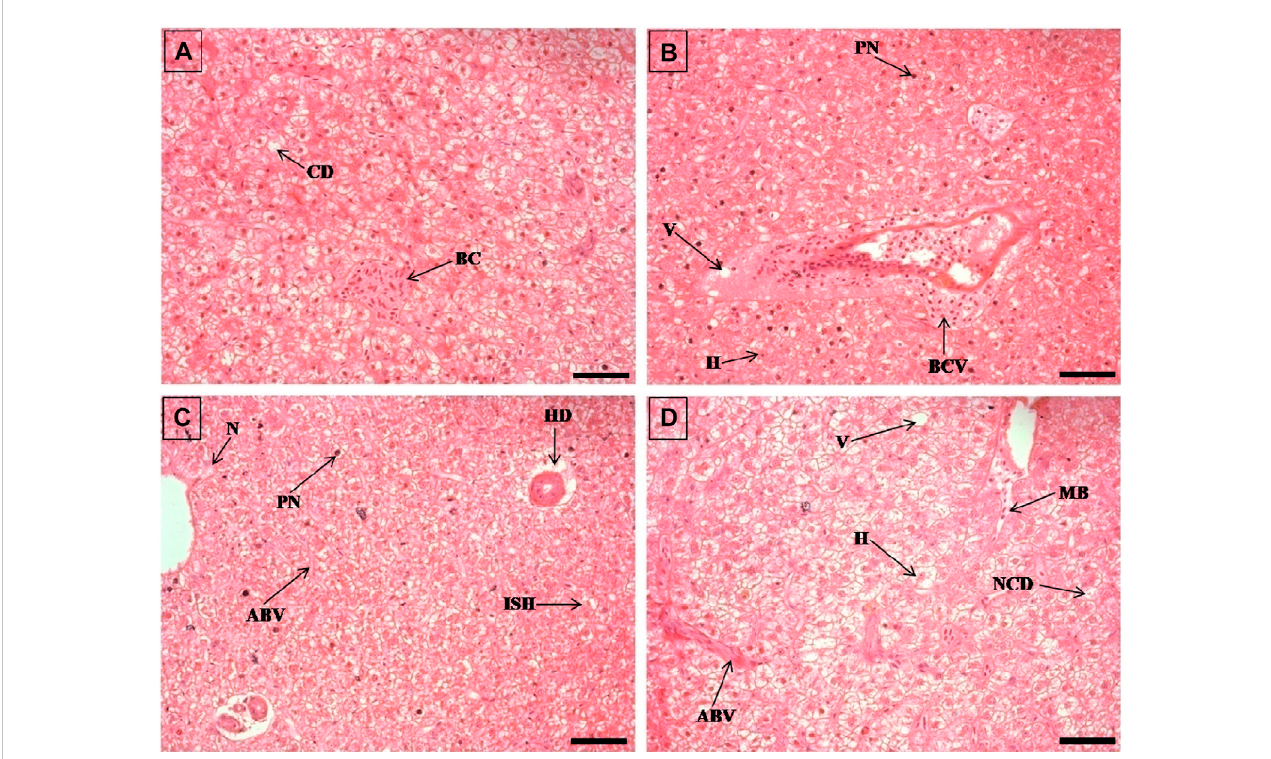
FIGURE 4 The histological sections (4 µm) of liver tissues from EB-administered golden mahseer on 21st day (A – D) of EB-medication. The histological changes in liver tissues of fi shes fed with EB doses (A) at 50 μ g/kg fi sh/day showing blood congestion (BC), cytoplsamic degeneration (CD); (B) at 100 μ g/kg fi sh/day showingvacuolization (V),pyknotic nuclei (PN),hypertrophy ofhepatocyte (H),blood congestionnear vein(BCV); (C) at250 μ g/kg fi sh/day showing pyknotic nuclei(PN),necrosis(N),irregularlyshapedhepatocytes(ISH),accumulationofbloodvessels(ABV),hepatocytedegeneration(HD); (D) at500 μ g/kg fi sh/ day showing vacuolization (V), hypertrophy (H), nuclear and cytoplasmic degeneration (NCD), migration of blood cells towards hepatocytes (MB), accumulation of blood vessels (ABV). The H&E stained sections are visualized at magni fi cation of ×400 under inverted light microscope (Olympus IX53, Canada). The scale bar value depicted in the right bottom corner (A – D) is 20